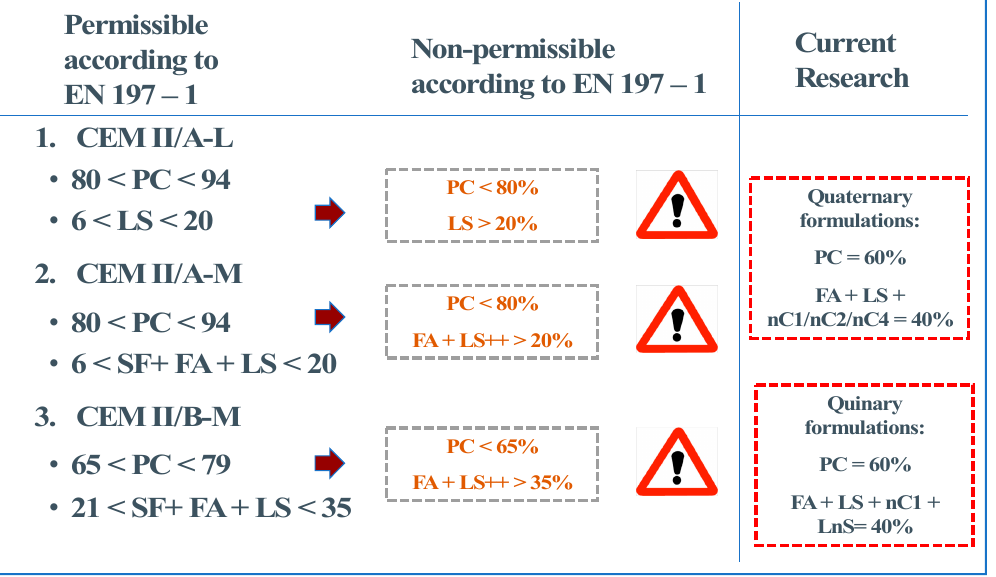
Figure 2. Eurocode limits of clinker substitution and supplementary cementitious materials (SCM) addition and target of current research.